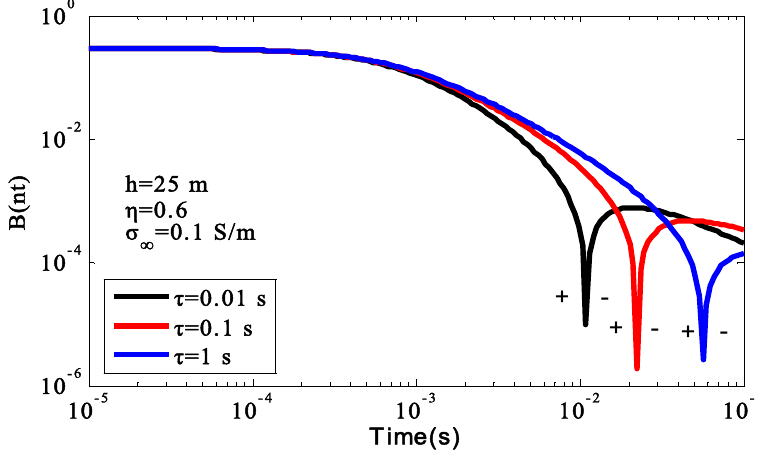
Figure 4. Influence of characteristic time constant on IP effect.